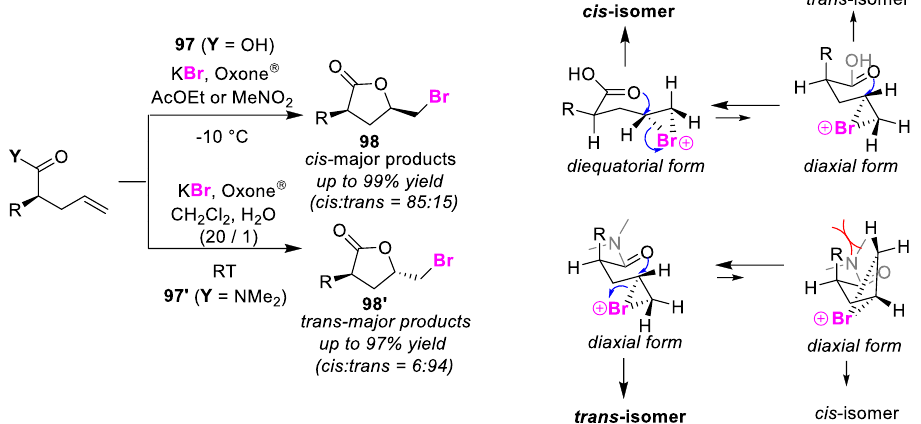
Figure 46. Stereoselective bromo-lactonizations of olefinic acids 97 and amides 9 7′ using a KBr/Oxone ® system.